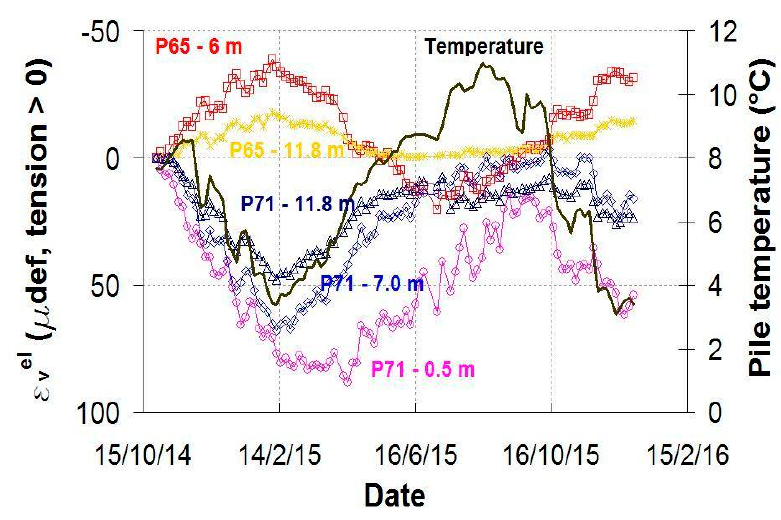
Figure 10. Typical data registered on thermoactive geostructures (Gonesse, France).